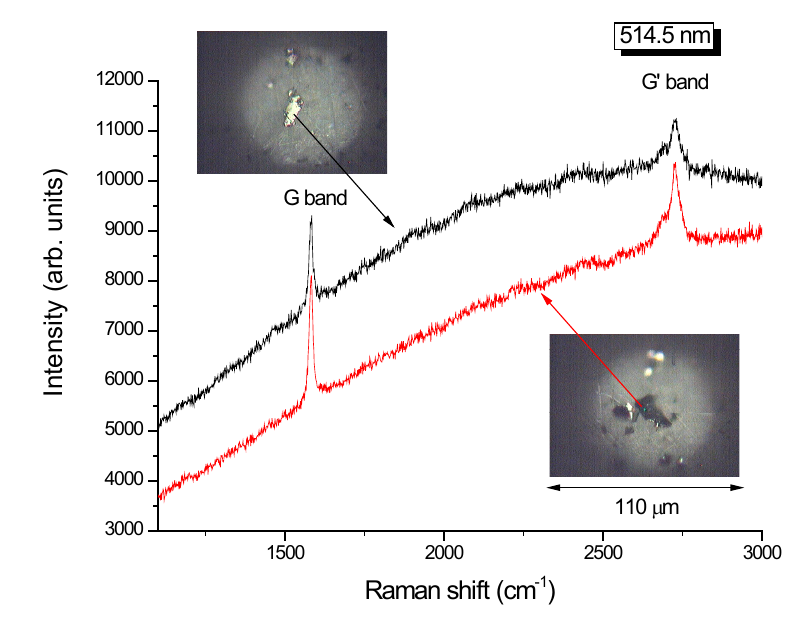
Figure 2. Micro-Raman spectra and corresponding optical images at different points on the filter.